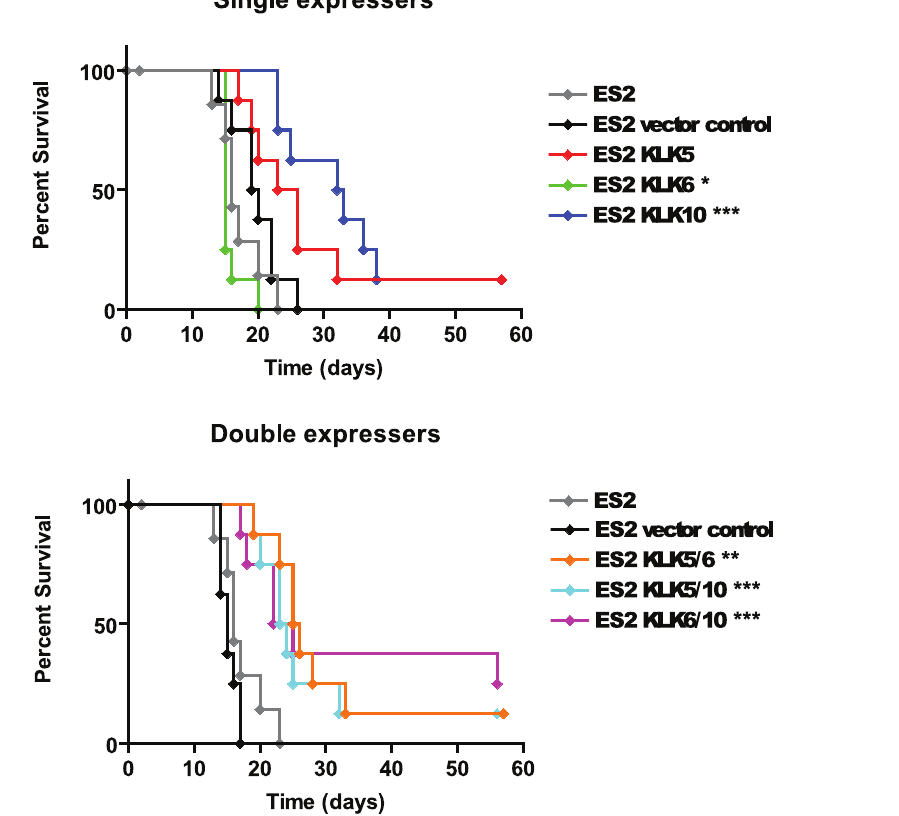
colonies in soft agar when compared to vector-only control, but did not alter the rate of proliferation over 96 h or modulate the ability of the clones to invade in a transwell assay.